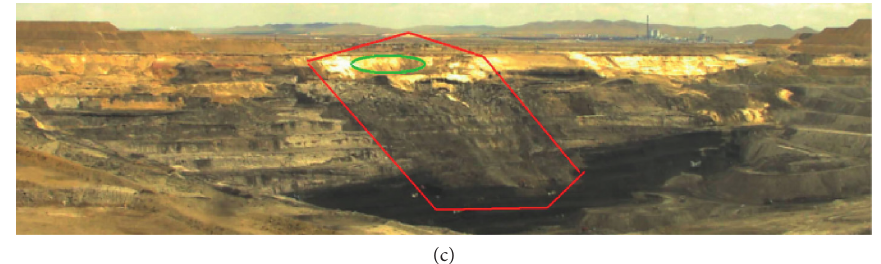
Figure 20: Aerial view of the landslide. (a) November 14, 2013. (b) February 15, 2014. (c) February 27, 2014 and April 26,